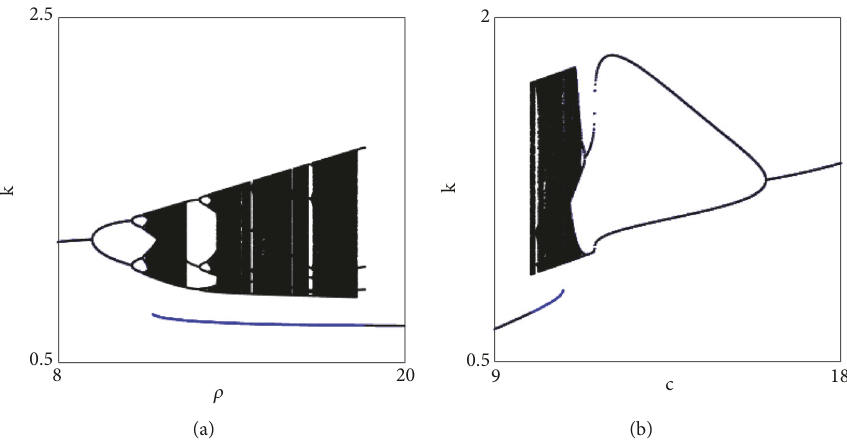
Figure 5: Bifurcation diagrams. Parameter values 𝛼 = .2 , 𝛽 = .4 , 𝛿 = 𝑛 = .7 , 𝑠 𝑟 = .8 , and 𝑠 𝑤 = .1 , initial conditions 𝑘 min (black) and 𝑘 0 = .02 (blue): (a) with respect to 𝜌 for 𝑐 = 10 ; (b) with respect to 𝑐 for 𝜌 = 18